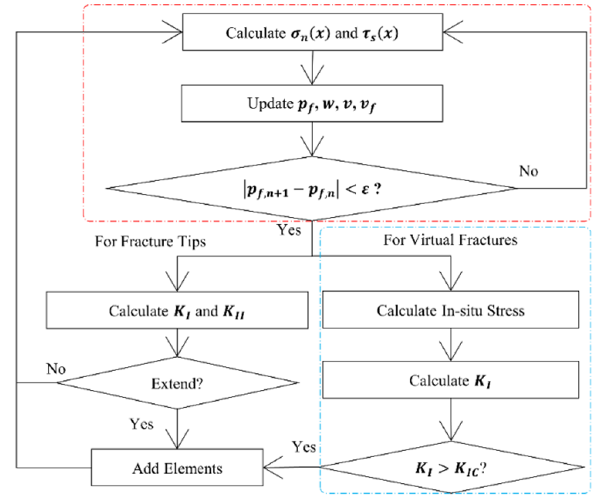
Figure 4. The flowchart of the